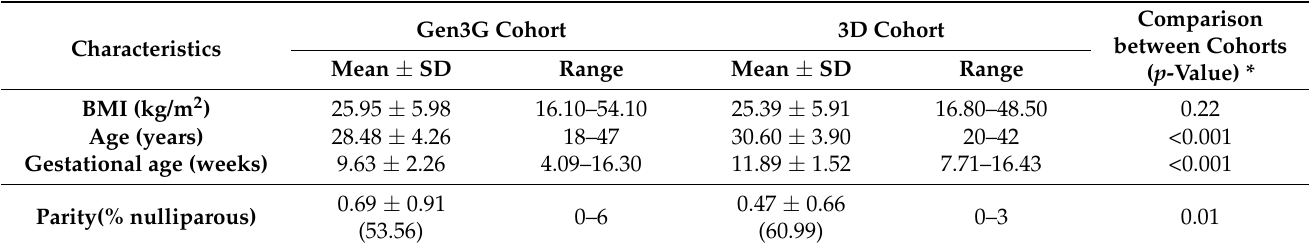
Table 1. Maternal characteristics at the first trimester of pregnancy in Gen3G ( n = 435) and 3D ( n = 223) cohorts.